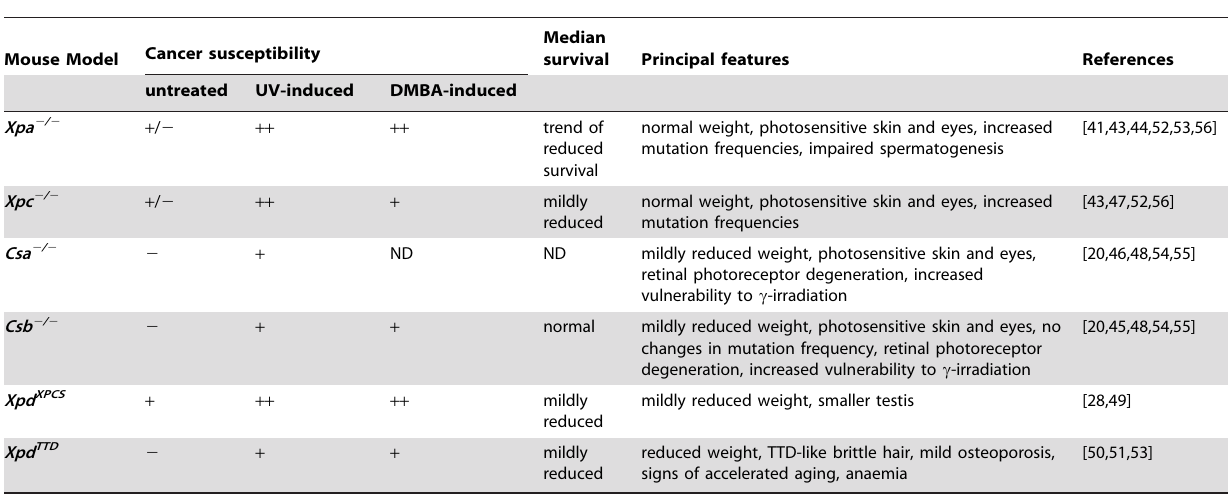
Table 2. Cancer susceptibility and principal features of NER–deficient mice.